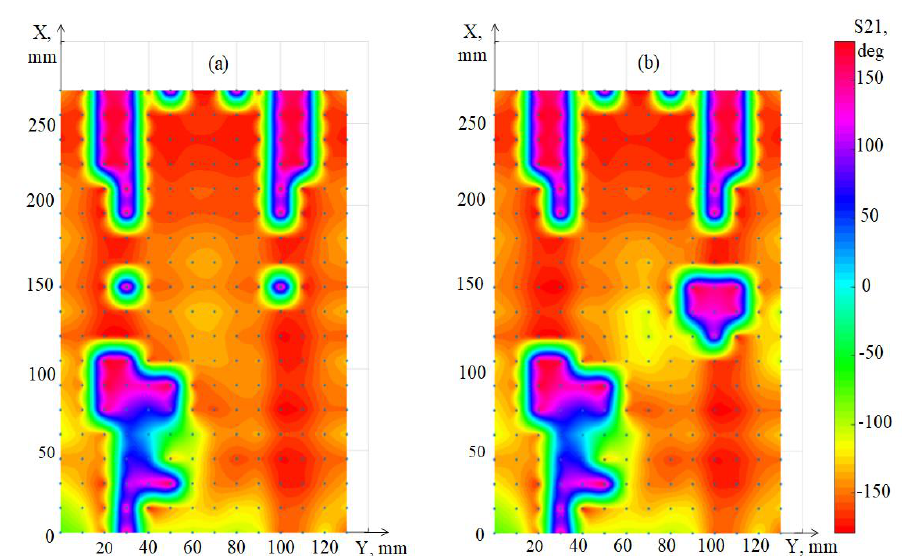
Fig. 6. Simulation results of the phase of the transmission coefficient estimation with a 900 MHz signal without heterogeneity (a) and with heterogeneity